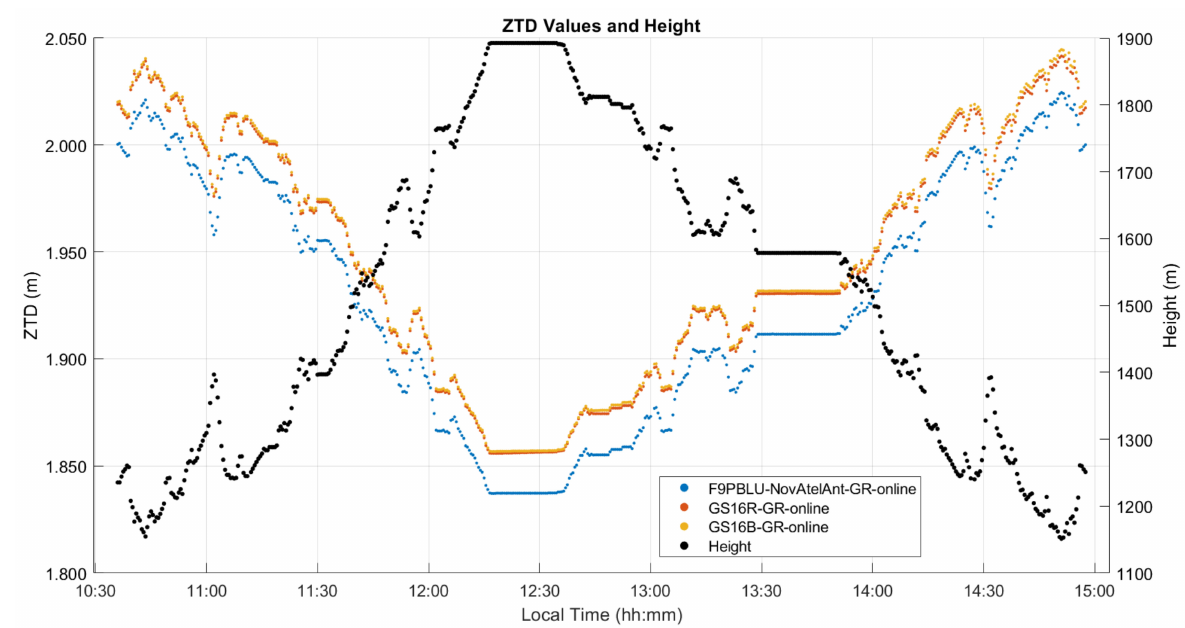
Figure 19. Kinematic dataset C PPP-derived ZTD and height profiles of full trajectory. Local time is UTC − 6:00.